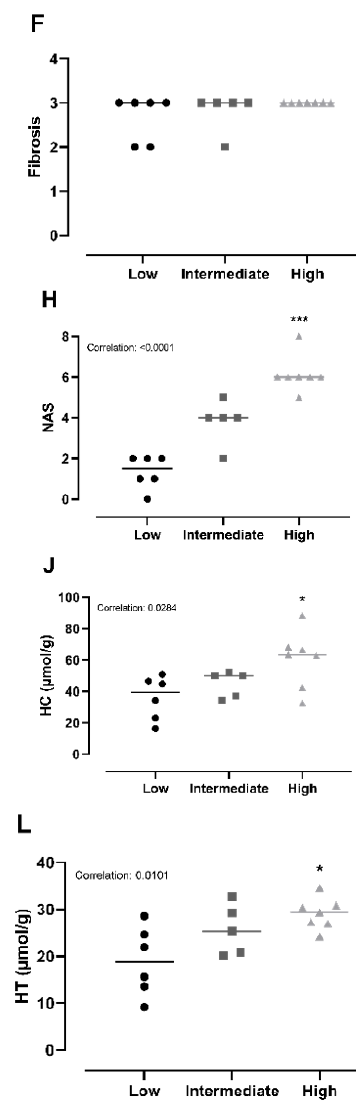
Figure 4. Subanalyses of histopathological markers of NASH and lipid accumulation relative to inflammatory status. ( A , B ) For Chow and CvitE, correlation between severity of steatosis and inflammation was detected. Low showed significantly reduced score compared with high in Chow and CvitE. ( C , D ) A low ballooning hepatocyte score correlated with a low inflammation score, with a significant decrease in low compared with high in Chow and CvitE. ( E , F ) In Chow, correlation between fibrosis and inflammation, with significant reduction in low compared with intermediate and high was detected. No correlation was observed in CvitE. ( G , H ) Chow and CvitE showed significant correlation between inflammation and NAS. In Chow, high was significantly increased compared with intermediate and low. In CvitE, high was significantly increased compared with low. ( I , J ) Correlation was observed between level of hepatic cholesterol and inflammation score in Chow and CvitE. In Chow and CvitE, low had significantly lower cholesterol levels compared with high. ( K , L ) Chow and CvitE showed correlation between hepatic triglyceride level and inflammation score, with significantly decreased levels in low compared with high. Data are presented as individual values with medians. * p < 0.05, ** p < 0.01, *** p < 0.001, compared with low; # p < 0.05, compared with intermediate. NAS, NAFLD activity score; HC, hepatic cholesterol; HT, hepatic triglyceride.